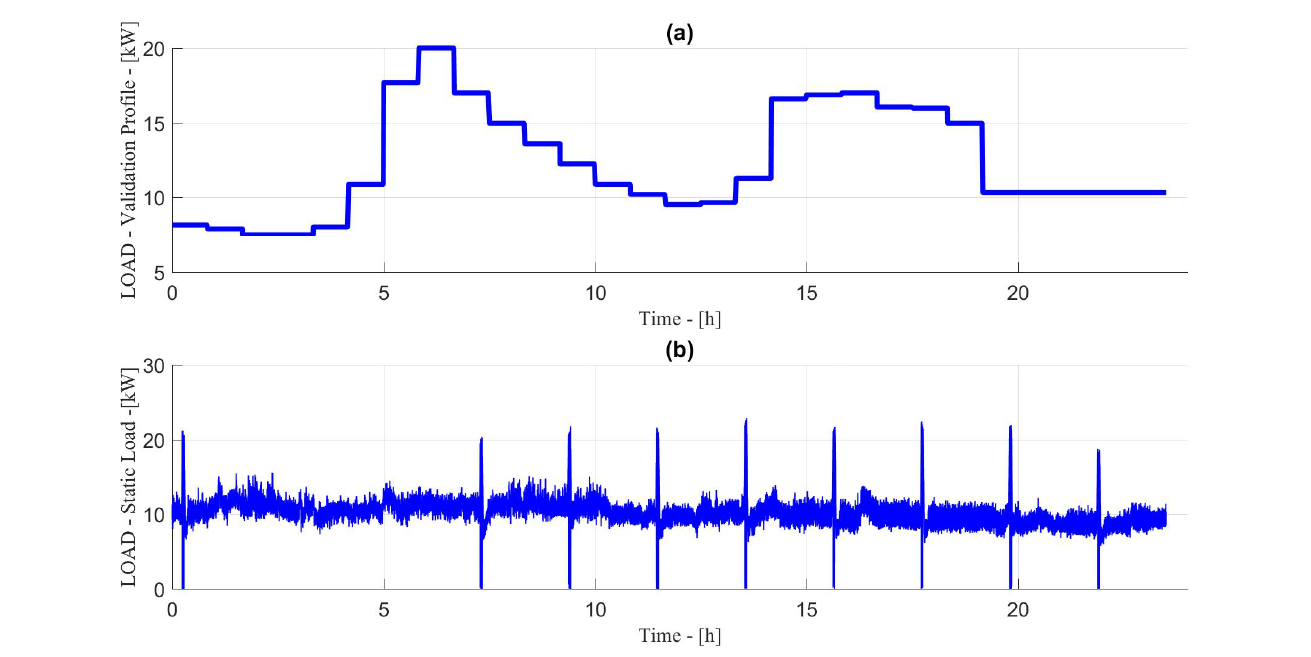
Figure 2. Load demand with active power in kW. ( a ) validation profile and ( b ) static